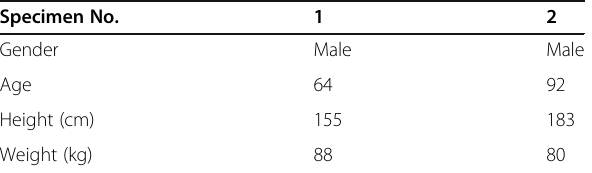
Table 1 Specifications of donated bodies Specimen No.